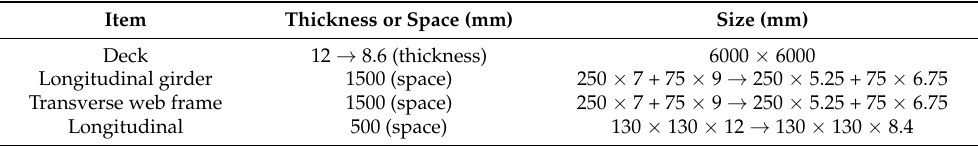
Table 6. Scantlings of the deck structural members considering corrosion wastage.